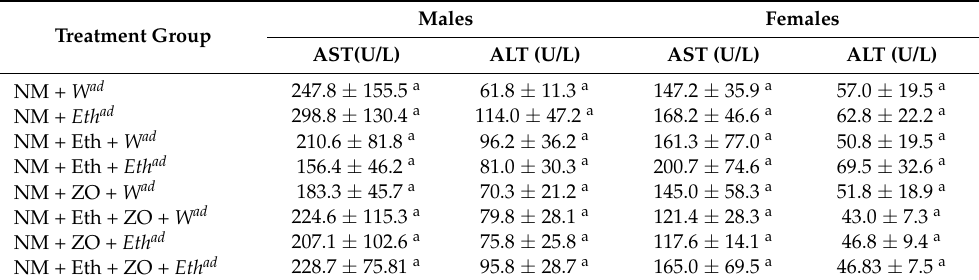
Table 2. Effect of neonatal orally administered zingerone on plasma liver enzyme activities in adult male and female rats drinking alcohol in adulthood.